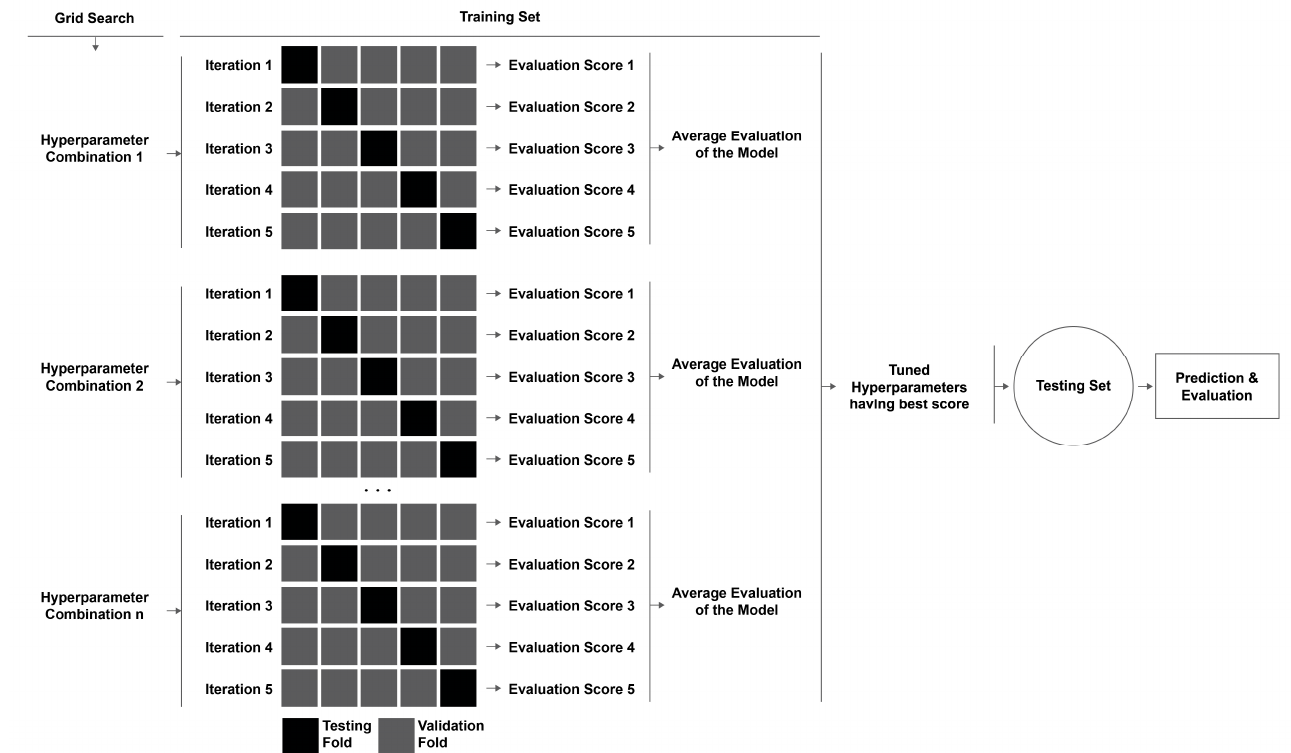
Figure 7. Hyperparameter tuning example in training set with 5-fold cross-validation, grid search, and final output prediction algorithm.